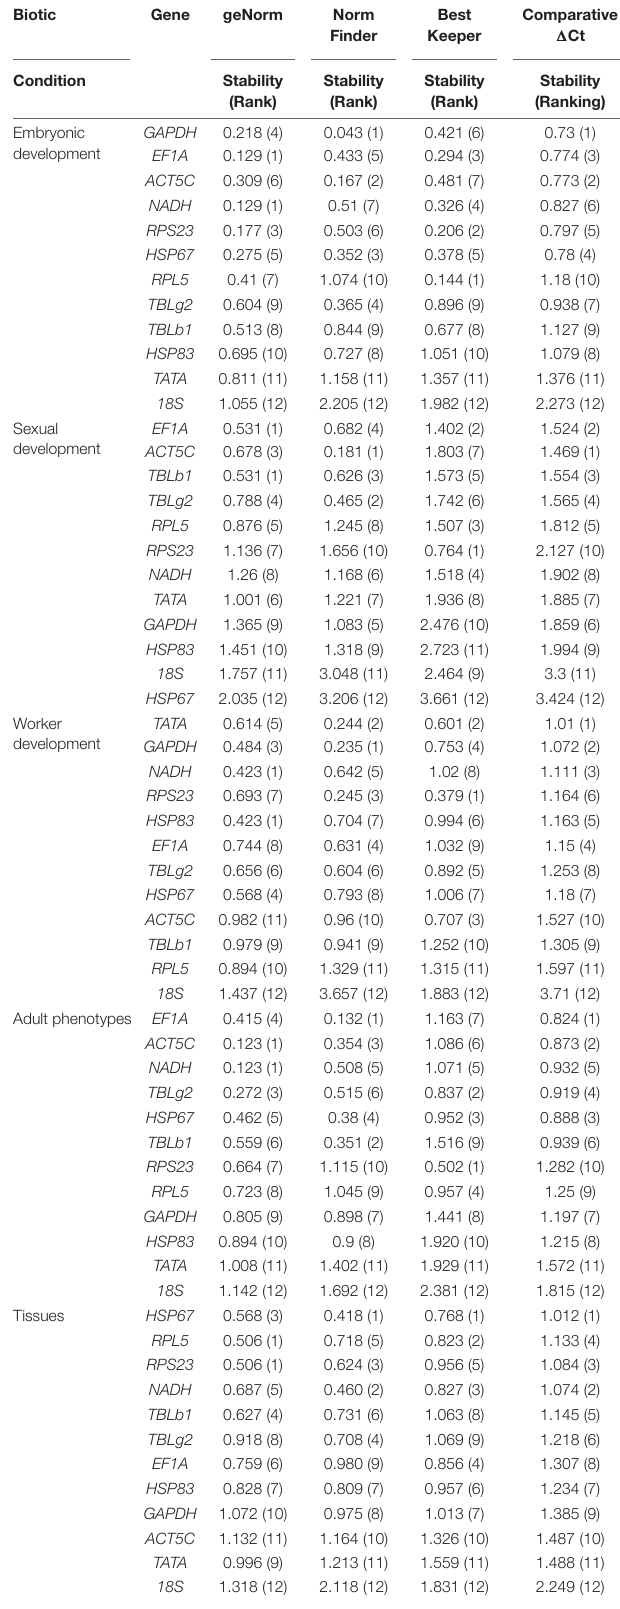
TABLE 2 | Stability of reference gene expression in different stages and